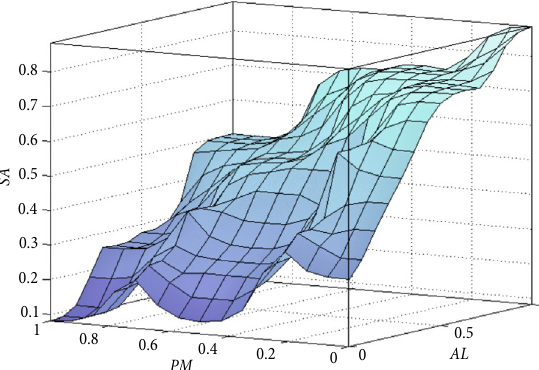
Fig. 7. Rule surface of FIS for the calculation of HAL